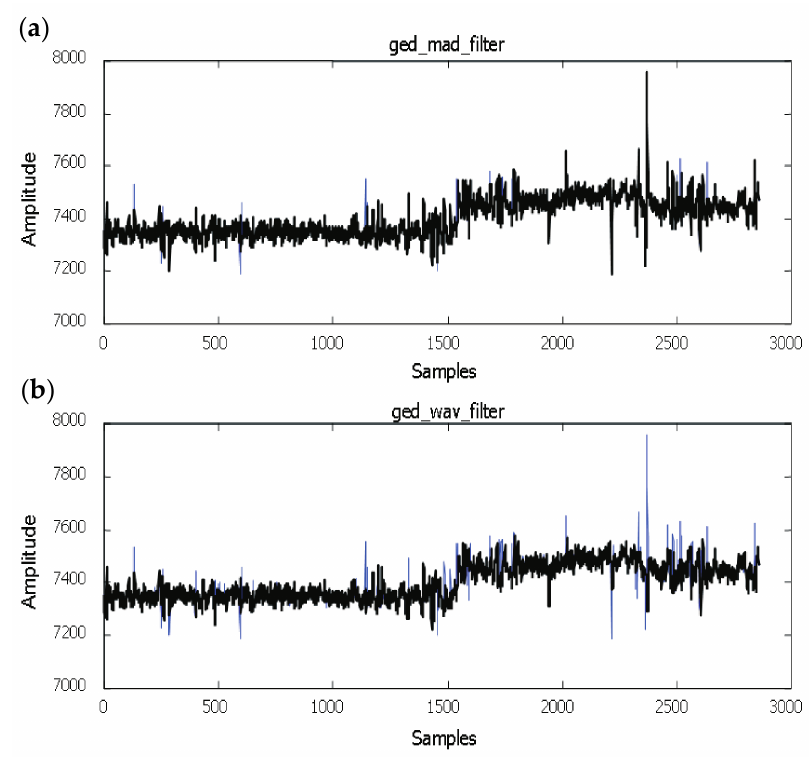
Figure 10. Comparison between ( a ) the presented algorithm in [10] and ( b ) that wavelet based on [5] proposed